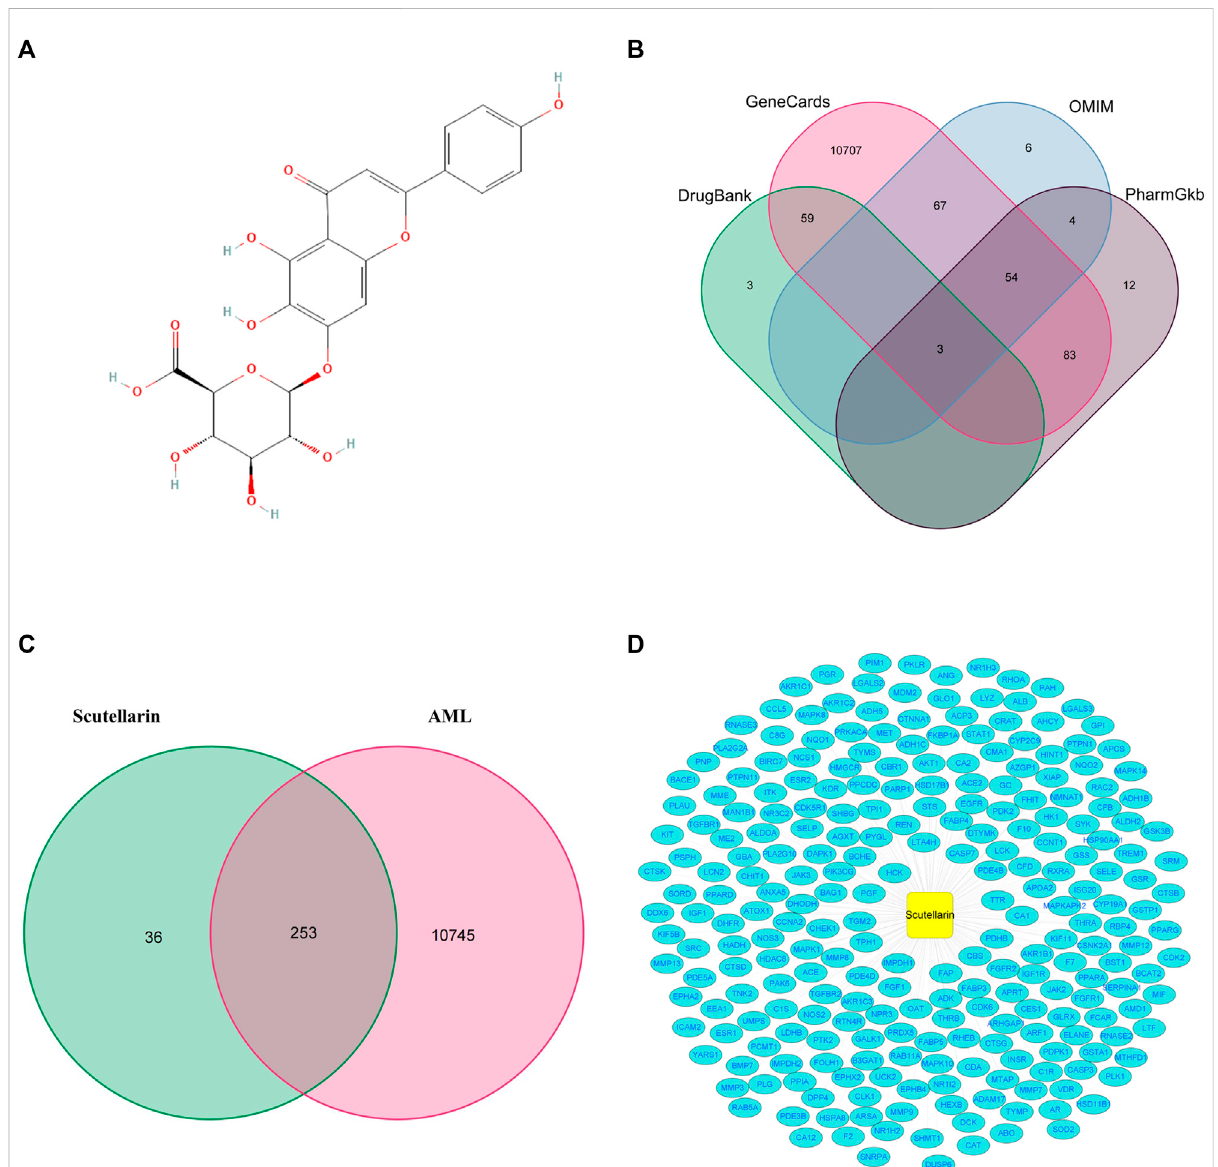
FIGURE 2 The precidiction of anti-AML targets ofscutellarin. (A) Chemical structure of scutellarin. (B) The collection of AML-related genes obtained from four databases. (C) The intersection of AML-related genes and target genes of scutellarin. (D) The network map of “ drug-disease-target ”